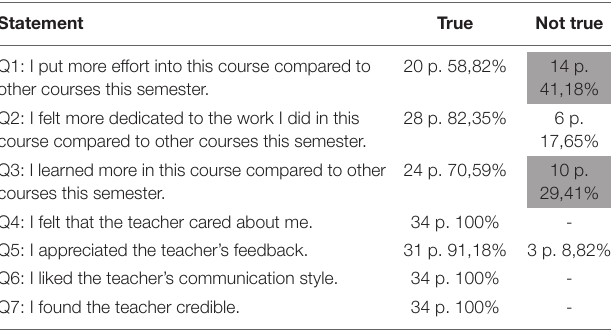
TABLE 2 | Overview of quantitative